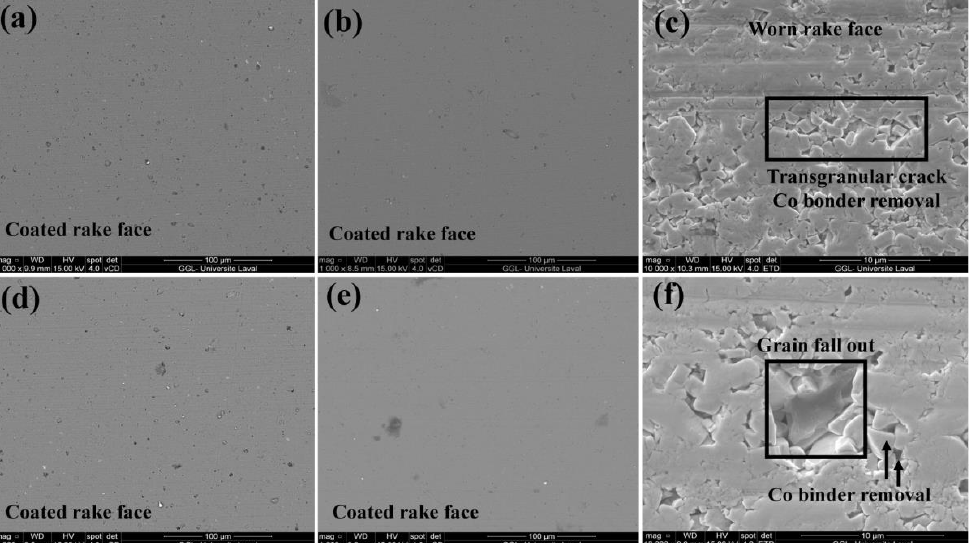
Figure 22. SEM micrographs of the rake face of ( a – c ) saws #2, 4, and 6, respectively after 480 min of sawing, and ( d – f ) saws #2, 4, and 6, respectively after 960 min of sawing. SEM characterization of the tip corners of the saws tested after 480 and 960 min of